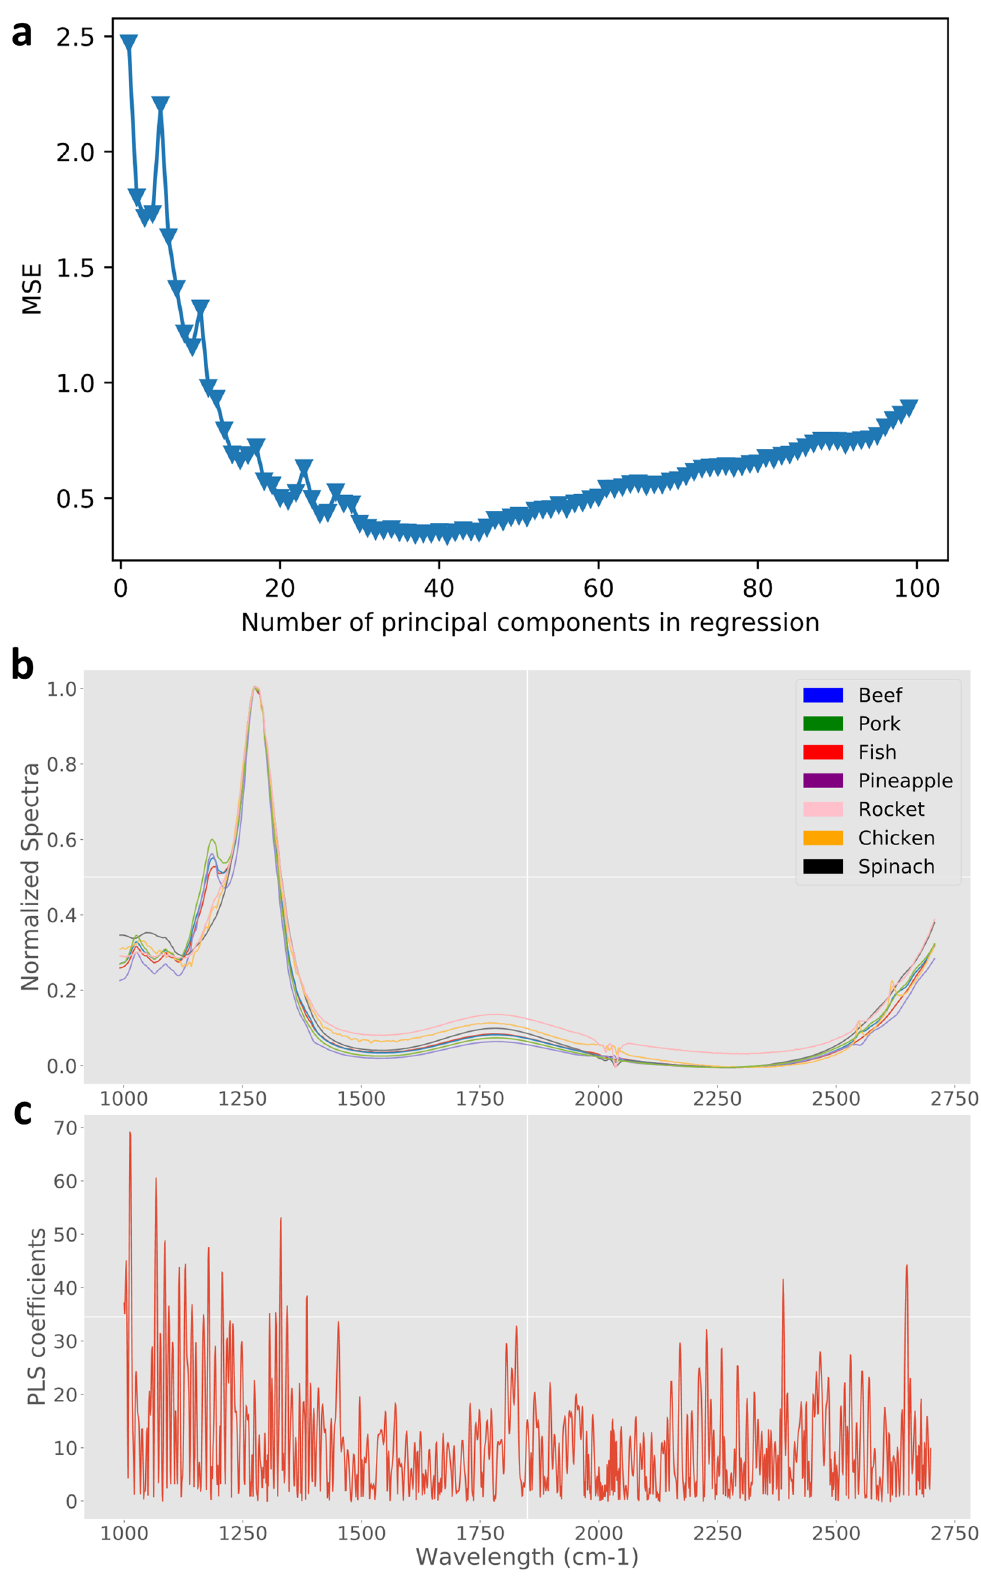
Figure 3. Supervised PLS dimensionality reduction overview: ( a ) mean square error vs. number of components (minimum MSE @ 41 components) across tenfold cross-validation, ( b ) sample spectra for each class type, ( c ) weights from PLS for each coefficient, i.e.